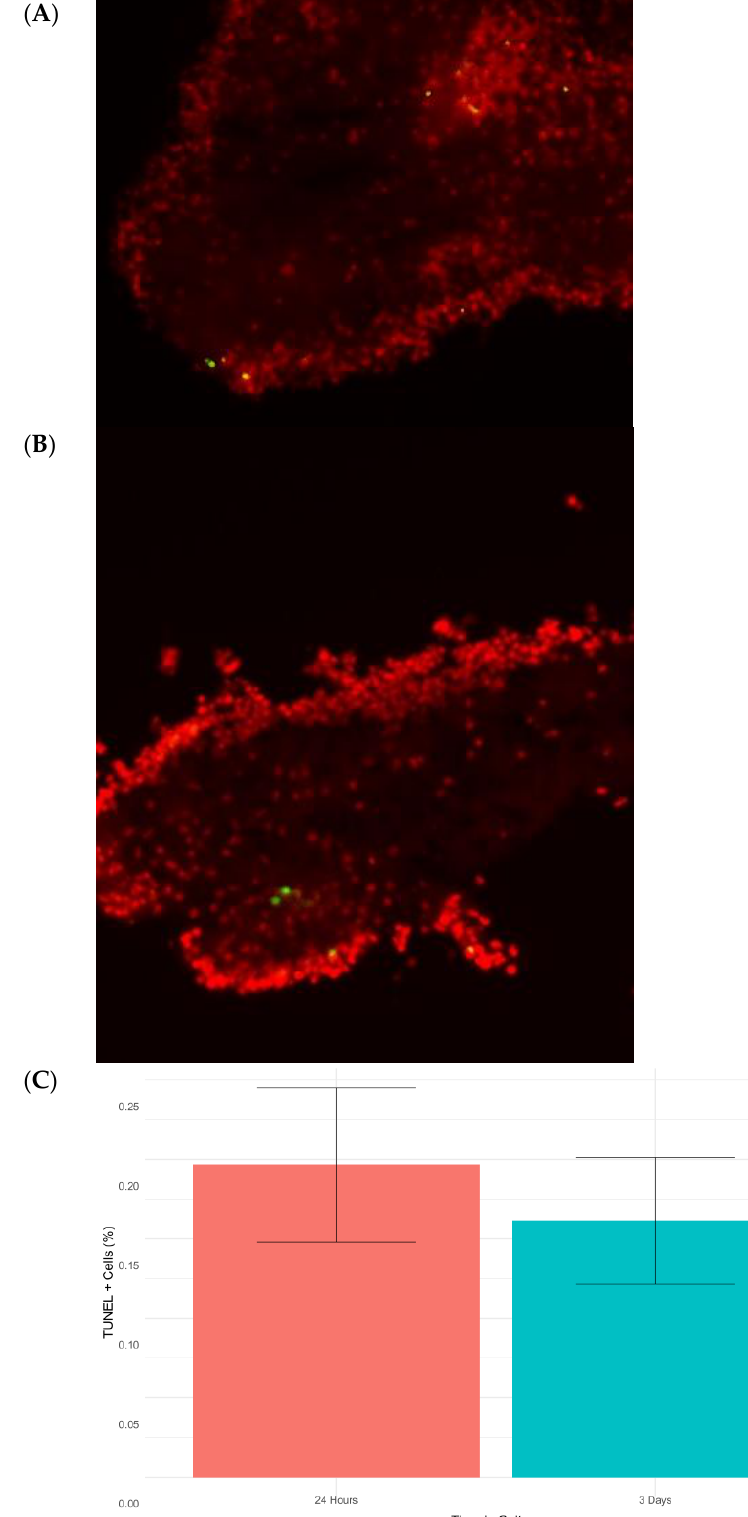
Figure 6. Micrographs of RNC explants at 3 days post-collagenase treatment ( A ) and 24 h post- collagenase treatment ( B ). Cell nuclei were stained with DAPI (red), and apoptotic cells were detected using TUNEL (green). Finally, the percentages of apoptotic cells in RNC explants placed in culture for 24 h and 3 d were calculated ( C ).